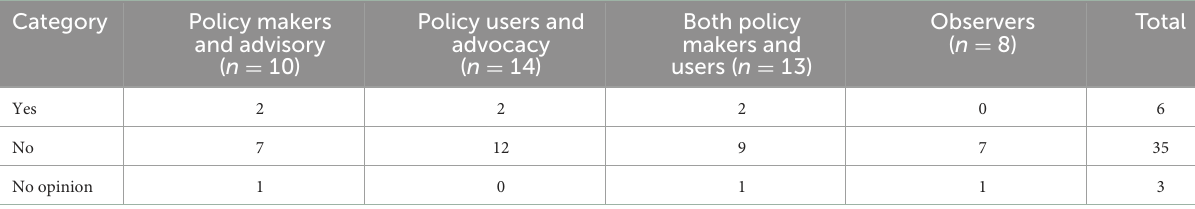
TABLE 2 Stakeholders about Ukrainian refugees and other groups of migrant and their temporary status ∗